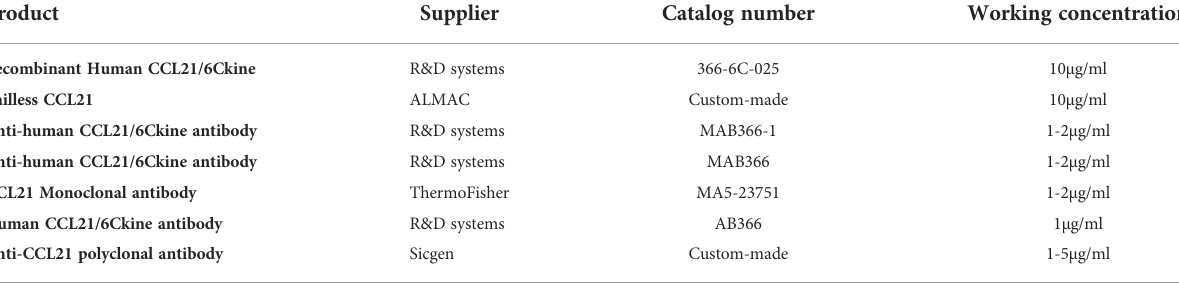
TABLE 1 Chemokines and antibodies used in SDS/PAGE and Western blot